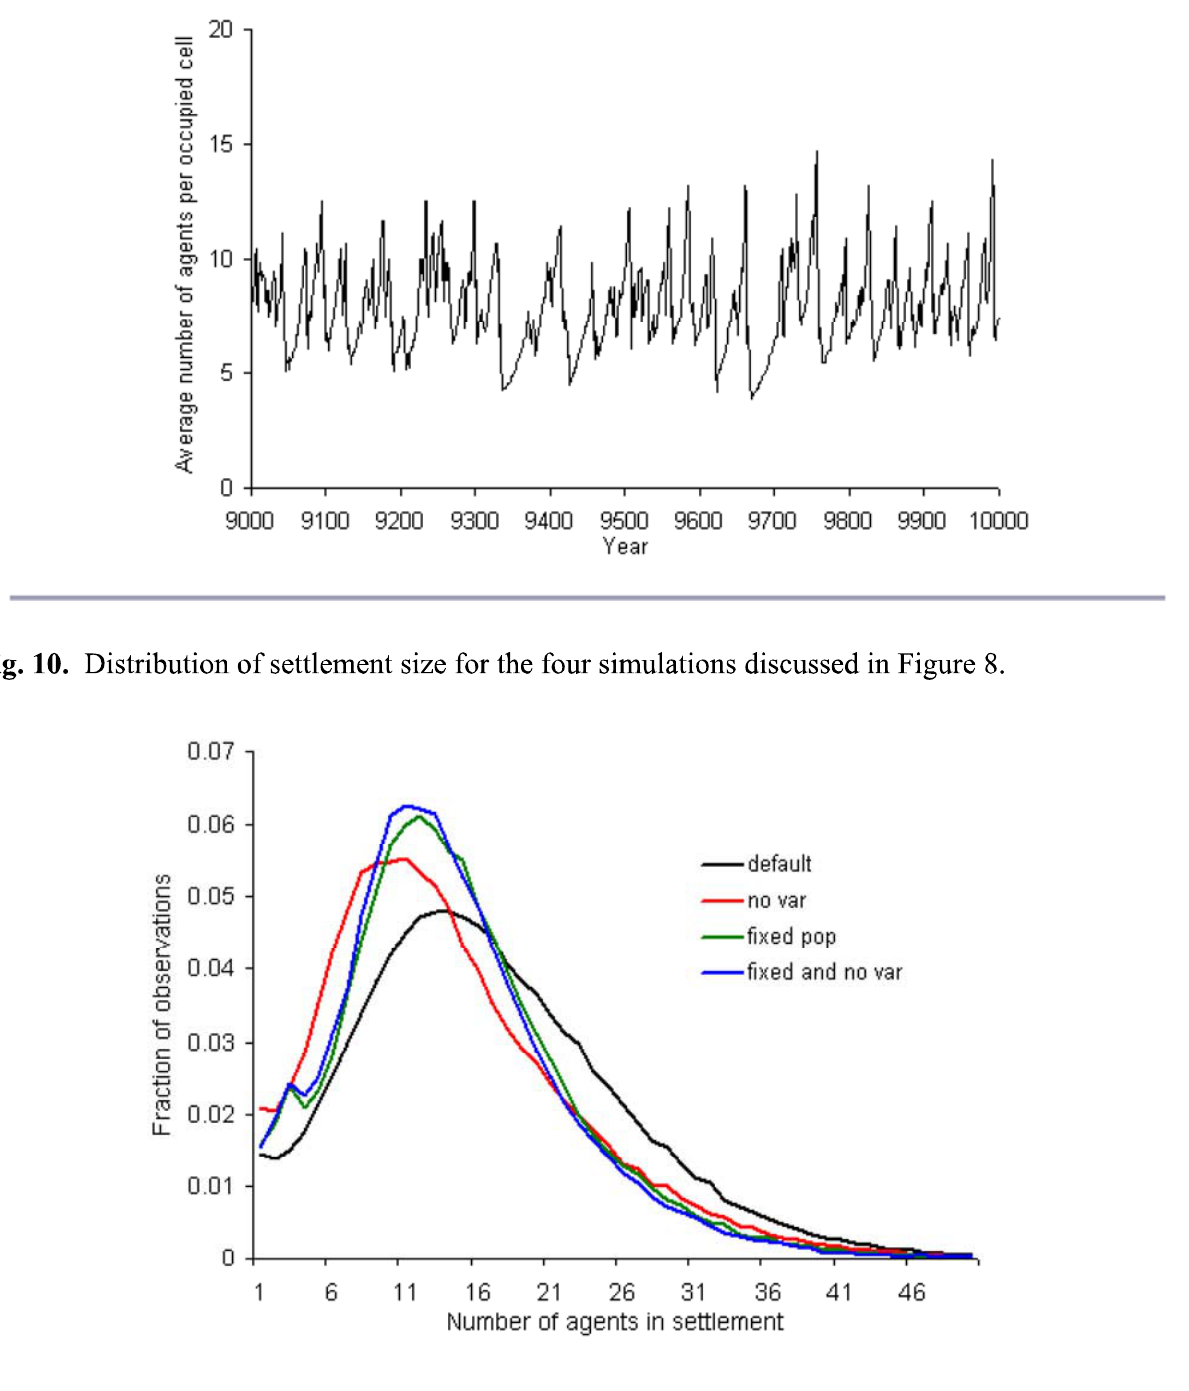
Fig. 9. Even a flat landscape with a fixed number of agents without rainfall variability has periods of aggregation and